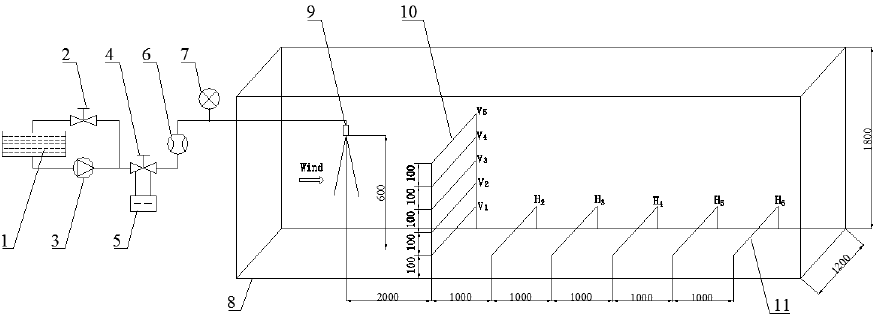
Figure 2. Measurement system of deposition distribution. 1. Water tank; 2. Return water pressure regulating valve; 3. Liquid pump; 4. Spray pressure regulating valve; 5. Timing relay; 6. Flowmeter; 7. Pressure gauge; 8. Wind tunnel; 9. Nozzle; 10. Vertical collection rack; 11. Horizontal collection rack.